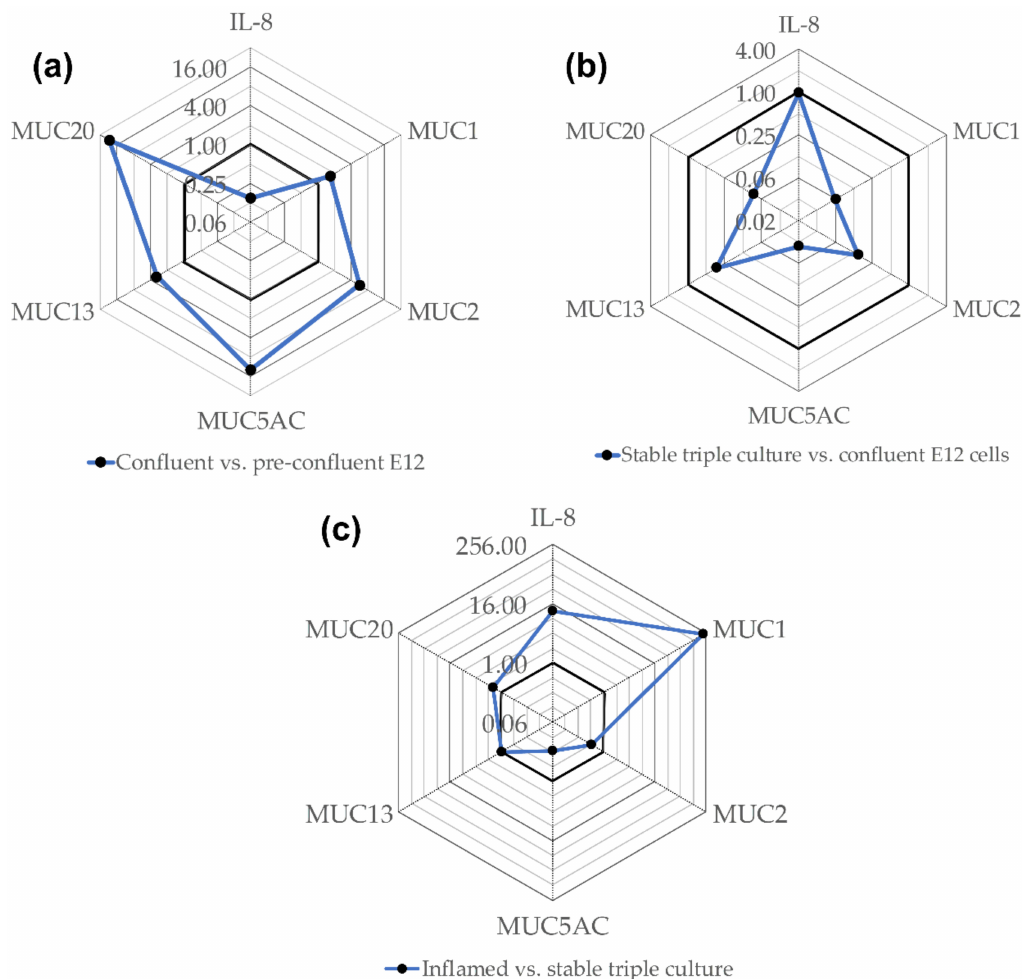
Figure 3. These radar charts show the gene expression in confluent E12 cells compared to pre-confluent E12 cells ( a ), in stable triple cultures compared to confluent E12 cells ( b ) and in inflamed compared to stable triple cultures ( c ) depicted as fold change. C T -values measured for untreated E12 cells and triple cultures were averaged. The fold change was calculated as ratio of the C T -value of one model and the C T -value of the next less complex model. The bold lines indicate fold change 1.0. Values closer to the center mean lower expression in the more complex model and vice